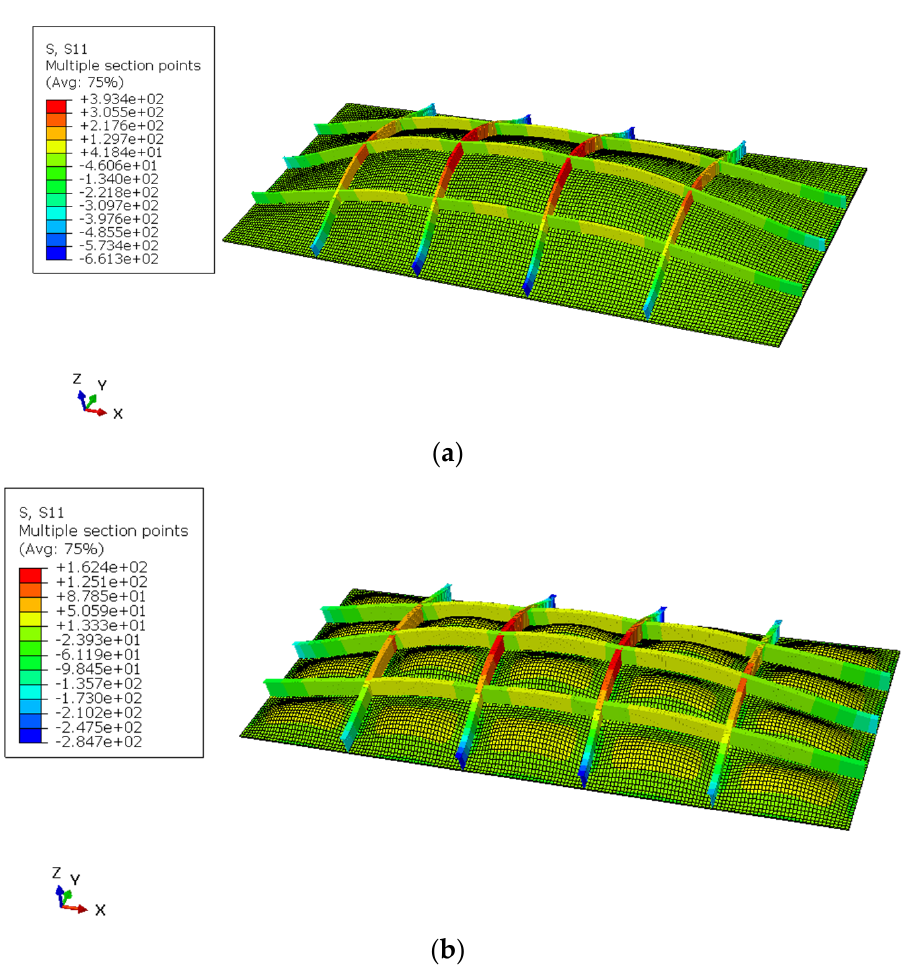
Figure 10. Stiffener bending normal stresses and deformation of a weak ( a ) and strong ( b ) stiffener system.